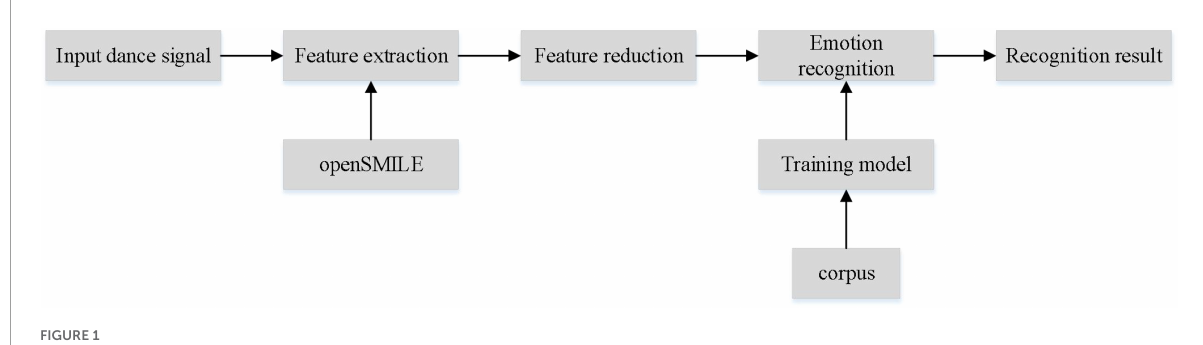
FIGURE1 Dance emotion recognition system block diagram.